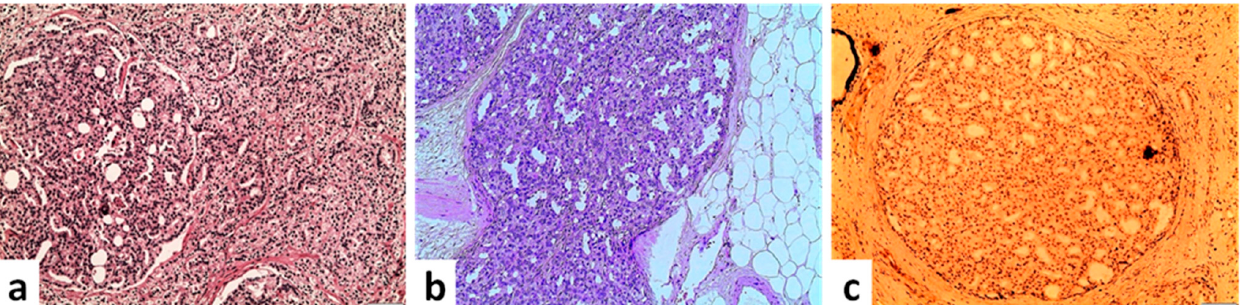
Figure 4. Invasive cribriform acinar carcinoma. ( a ) Merging of cribriform structure to clearly invasive carcinoma (×100). ( b ) Complex cribriform structure invading in the periprostatic adipose tissue verifies the invasive nature of the structure (×100). ( c ) Absence of staining for basal cell marker verifies the invasive nature of these cribriform glandular structure (Gleason pattern 4) (Immunohistochemistry with the basal cell marker high molecular cytokeratin 34 β E12) (×100) (scale bar is 50 μ m).